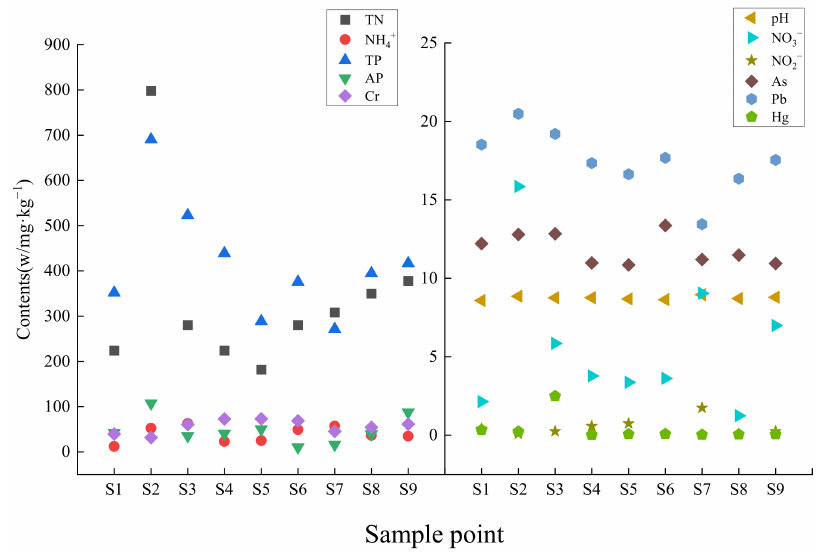
Figure 2. Scatter plot of physical-chemical properties and heavy metals in surface sediments. (Note: pH has no